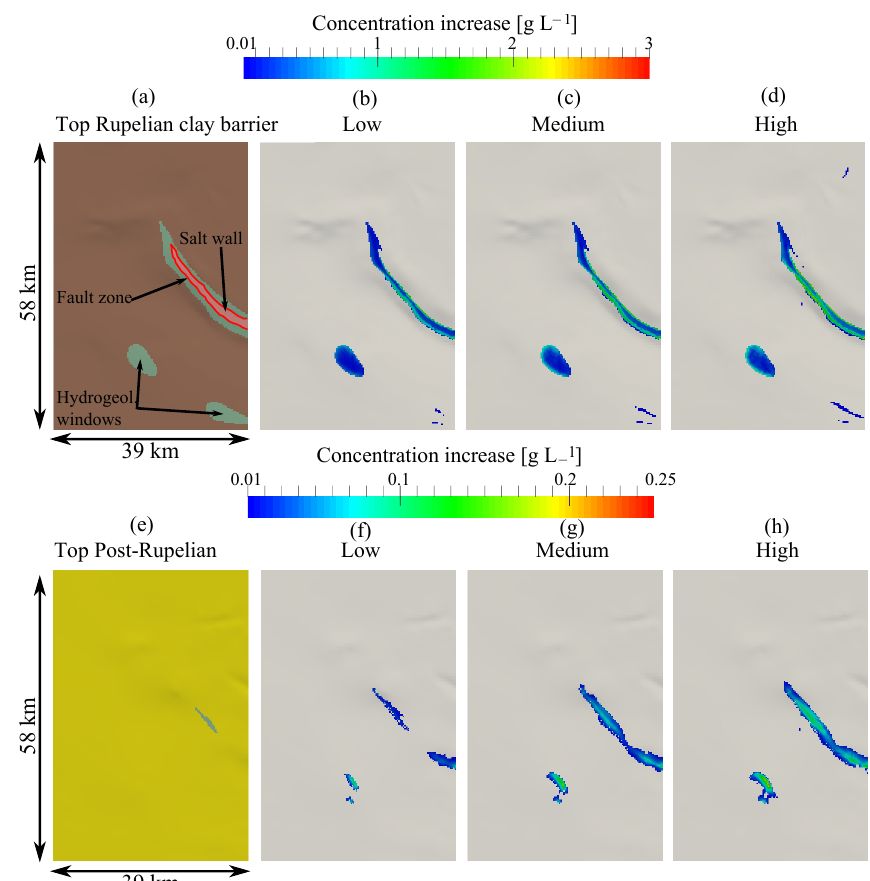
Figure 9. Scenario study 1. Top row: view of top of the Rupelian clay barrier. Panel (a) shows the top view of the geology (as shown in Fig. 7a). Panels (b) , (c) , and (d) show the salt concentration increase after 50 years of injection for the three different scenarios (low, medium, and high) with increasing initial salt gradients. Concentration increases below 0.01gL − 1 are not shown. Bottom row: view of top of the Post-Rupelian. Panel (e) shows the top view of the geology of the Post-Rupelian. Panels (f) , (g) , and (h) show the salt concentration increase after 50 years of injection, again for the same three scenarios. Note the different scales on the legends for the top and bottom